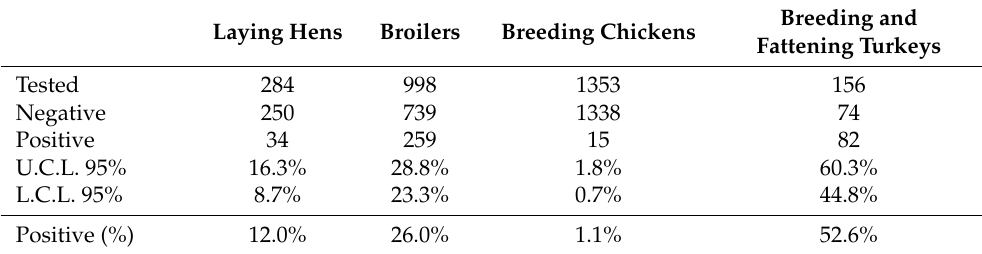
Table 4. Percentages of positive results, according to the sampling method.